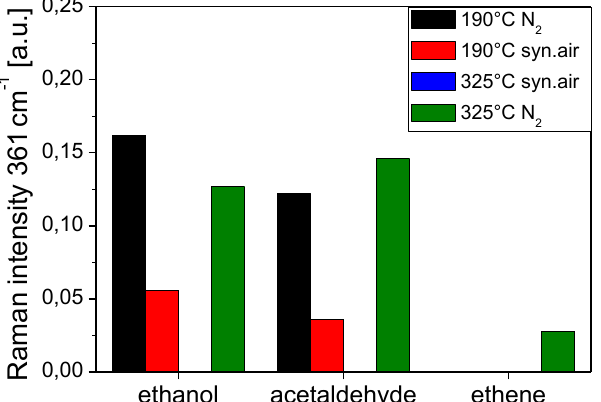
Figure 9. Influence of gas environment and temperature on the degree of reduction of an indium oxide gas sensor. The intensity of the Raman band at 361 cm −1 was normalized to that at 307 cm −1 and corrected for the intensity in the carrier gas. Reproduced from [32].